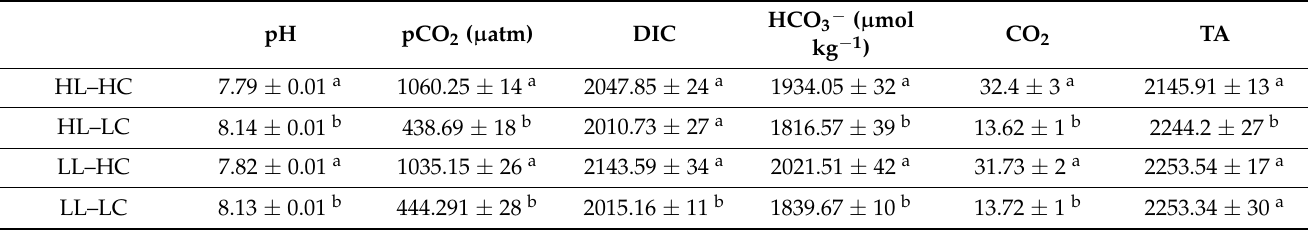
Table 1. Parameters of the seawater carbonate system under high light (HL) or low light